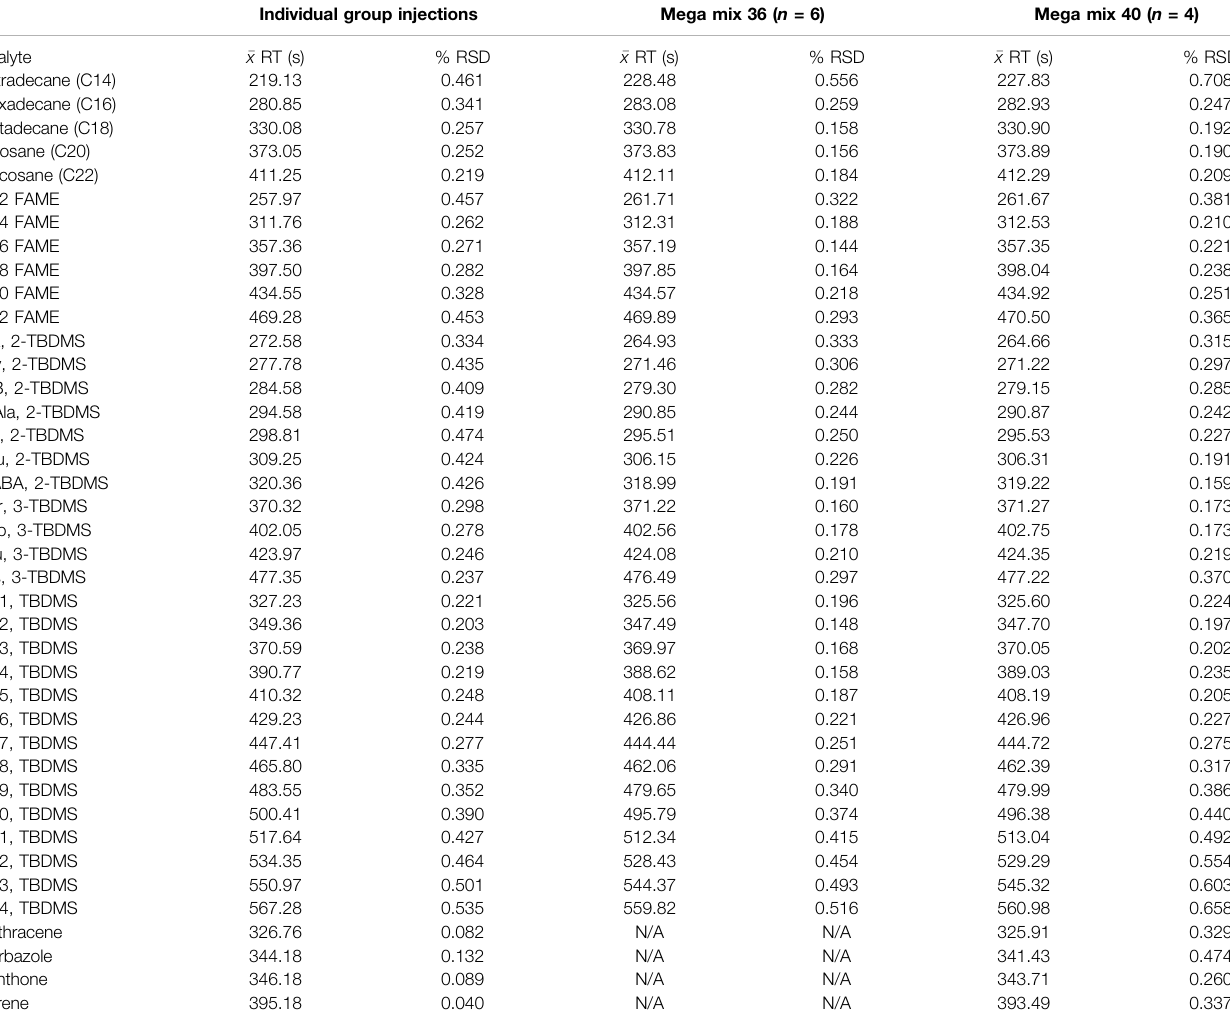
TABLE 6 | Comparison of retention times and % RSD values for the individual chemical family averages (from Table 4 ) and those from Mega Mix 36 and Mega Mix 40. Individual group